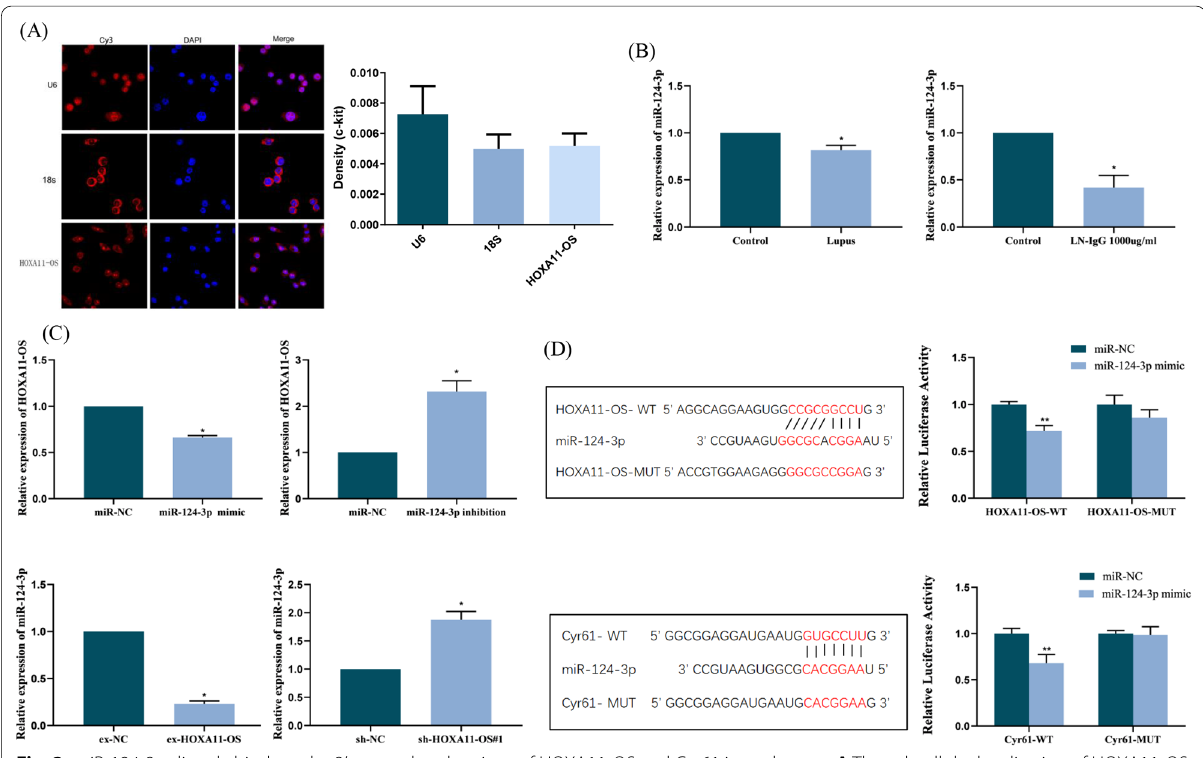
Fig. 3 miR-124-3p directly binds to the 3’ untranslated regions of HOXA11-OS and Cyr61 in podocytes. A The subcellular localization of HOXA11-OS was detected by FISH assay. The expression of 18S, U6, and HOXA11-OS were similar, and there was no statistical difference in optical density. B The expression of miR-124-3p in the kidney tissue of lupus mice and podocyte injury model was detected by qRT-PCR. * P < 0.01 vs. control group. C The expression of HOXA11-OS in miR-124-3p mimic or inhibition cell lines and the expression of miR-124-3p in HOXA11-OS overexpression or knockdown cell lines were detected by qRT-PCR. * P < 0.001 vs. miR-NC/ex-NC/sh-NC. D The binding sites of miR-124-3p on HOXA11-OS and Cyr61 in HOXA11-OS-wild-type (WT) and Cyr61-WT, and the mutation sites in HOXA11-OS-mutant (MUT) and Cyr61-MUT are indicated in red. Bi-luciferase reporter genes were detected 48 h after transfection of HOXA11-OS-WT, Cyr61-WT, HOXA11-OS-MUT, or Cyr61-MUT and miR-124-3p mimic or miR-NC. ** P < 0.01 vs. HOXA11-OS-WT miR-NC/Cyr61-WT + +